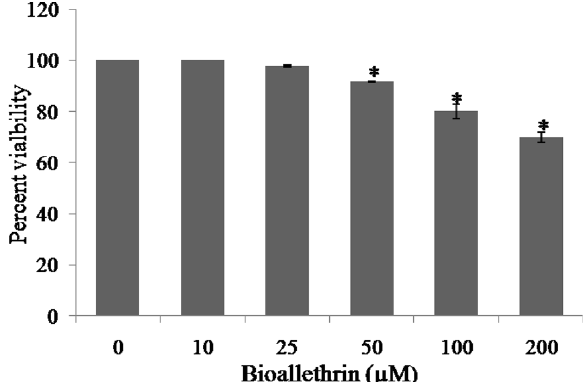
Figure 1. Effect of bioallethrin on viability of human lymphocytes. Cell viability was determined by the MTT assay as described in “Methods”. Absorbance of samples was read at 570 nm. Viability of control samples was taken as 100%. Lymphocytes were incubated with bioallethrin for 2 h at 37 °C. Results are ± standard deviation of six different samples. *Significantly different from control at p < 0.05. MTT 3-(4,5-dimethylthiazol-2-yl)-2,5- diphenyl tetrazolium